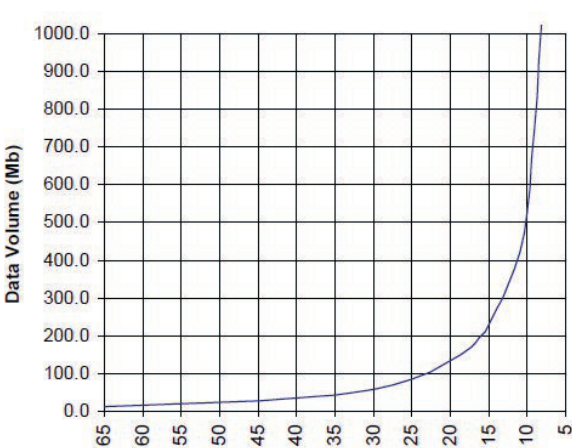
Fig. 1. Relation between data size and scanning resolutions Scanning resolutions from 84.7 µm (300 dpi) to 21.2 µm (1200 dpi) will yield ground pixel dimensions